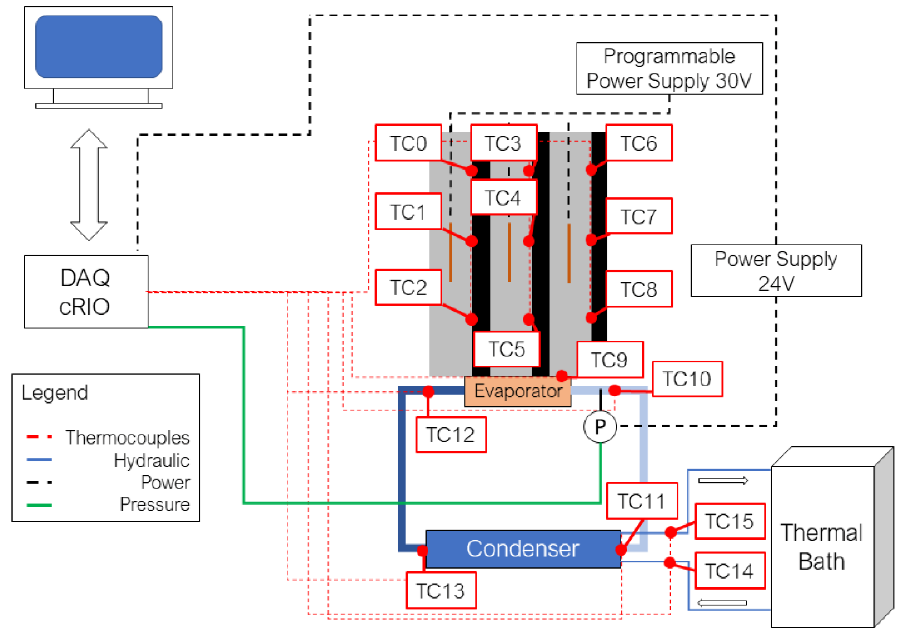
Figure 3. Block diagram of the experimental set up with details of thermocouples positioning and numbering, as well as instrumentation utilized. The thermocouples TC0 to TC8 measure the temperature on the cell surface in contact with the graphite sheet.